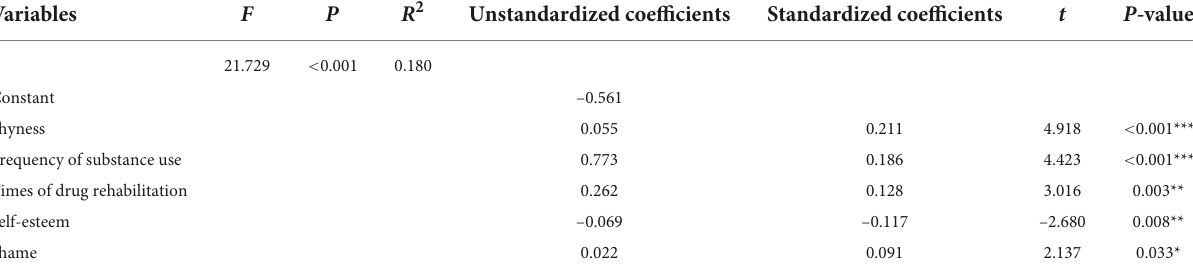
TABLE 4 Multiple linear regression analyses of drug